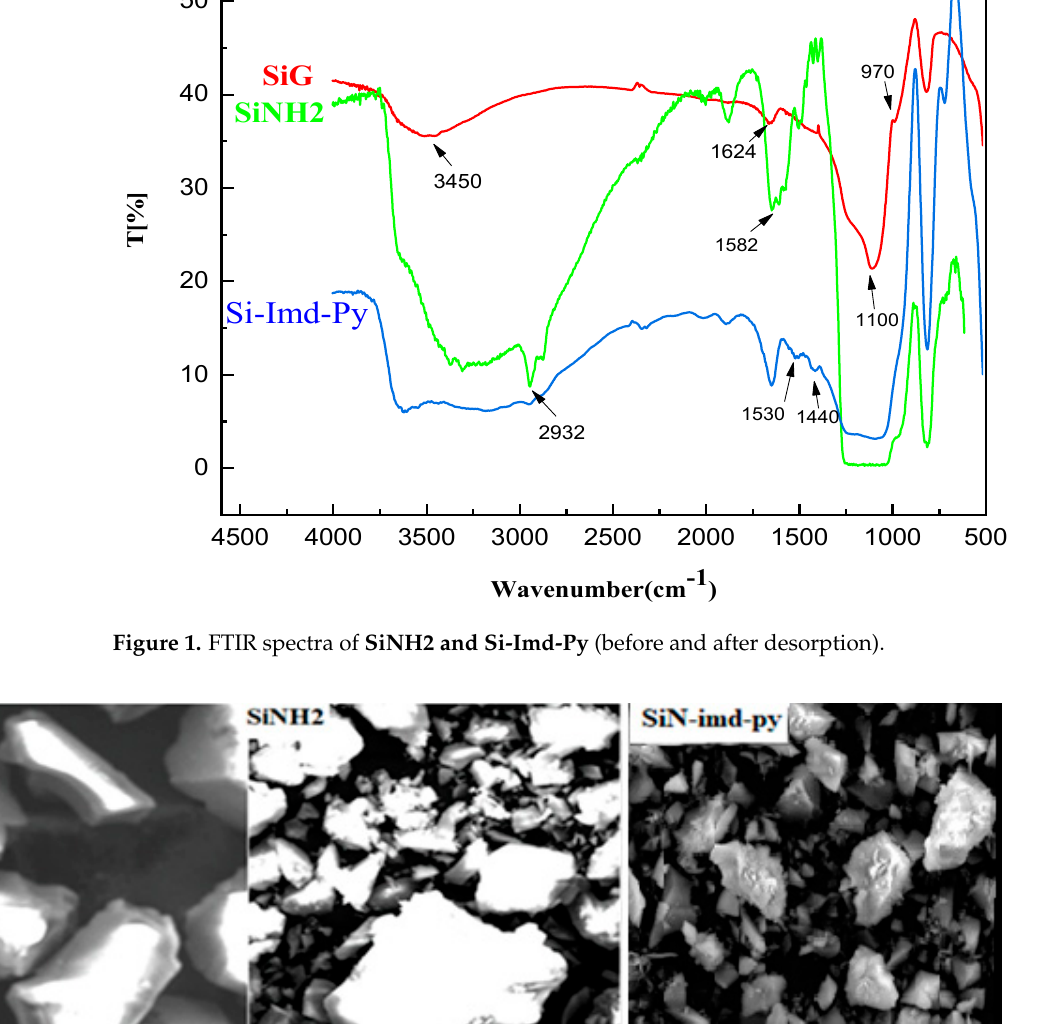
Figure 2. SEM micrographs of SiG , SiNH2 and SiN-imd-py